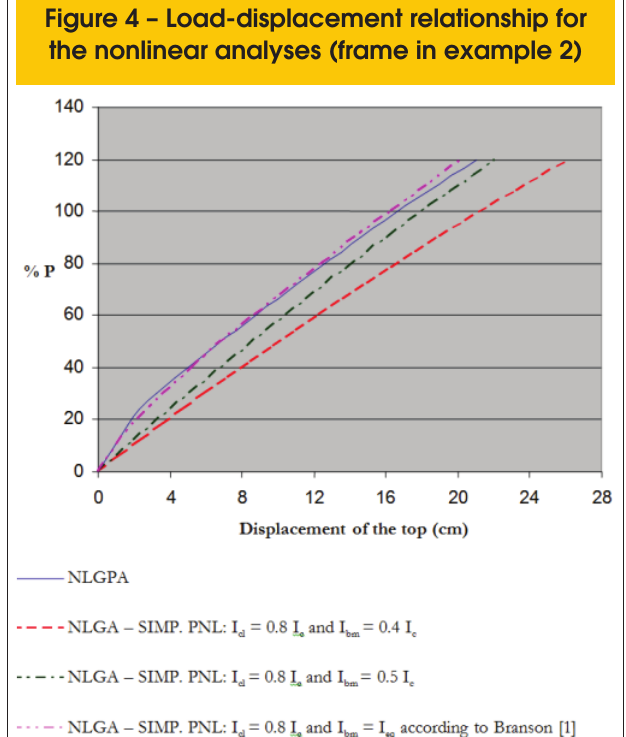
Figure 4 – Load-displacement relationship for the nonlinear analyses (frame in example 2)